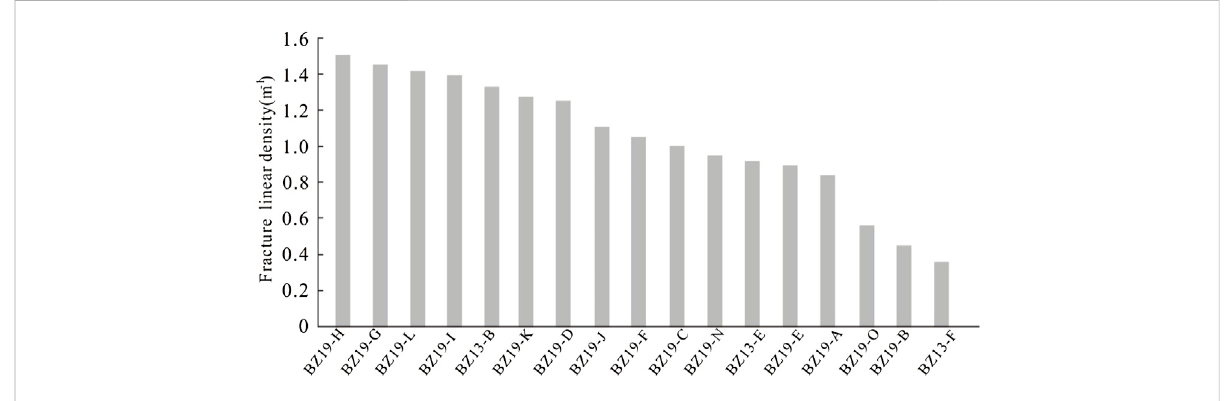
FIGURE 11 Histogram of fracture linear density for different wells in the study area (Fracture linear density is derived from the imaging logs of 17